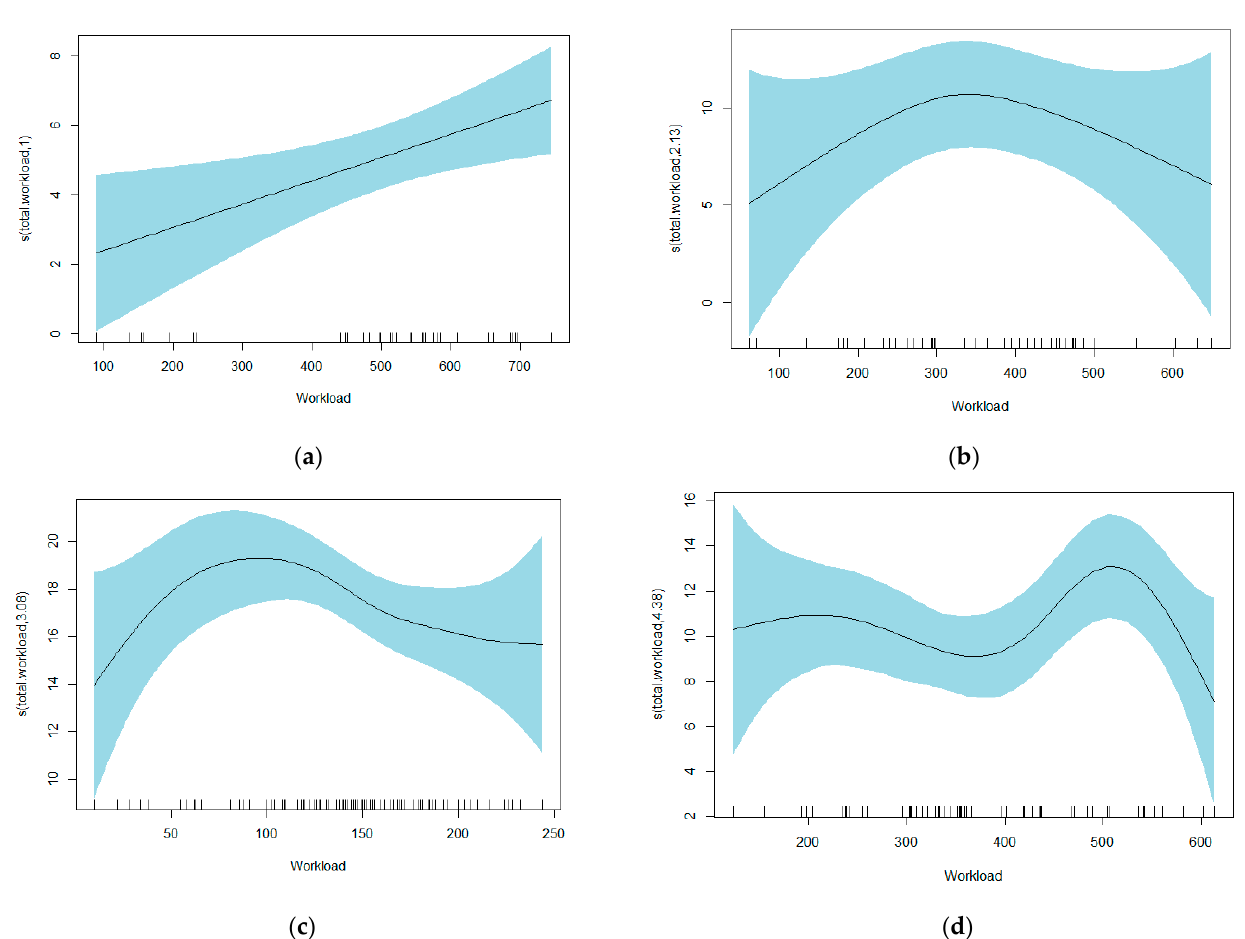
Figure 3. GAM plots of workload against processing speed. ( a ) BPIC 17 User 53/W_Validate application (edf = 1); ( b ) BPIC 12 User 11009/W_Completeren aanvraag (edf = 2); ( c ) BPIC 12 User 10972/W_Valideren aanvraag (edf = 3); ( d ) BPIC 17 User 24/W_Complete application (edf = 4). Information 2020 , 11 , x FOR PEER REVIEW